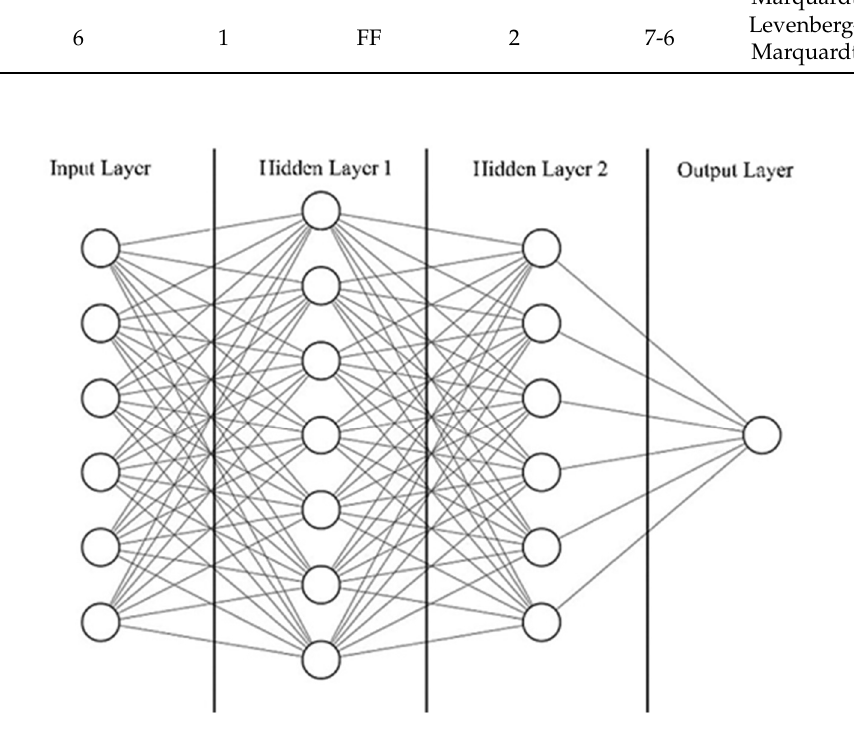
Figure 7. Feed-forward ANN with 6-7-6-1 structure. Table 5. Features of ABC algorithm in the proposed ANN model.